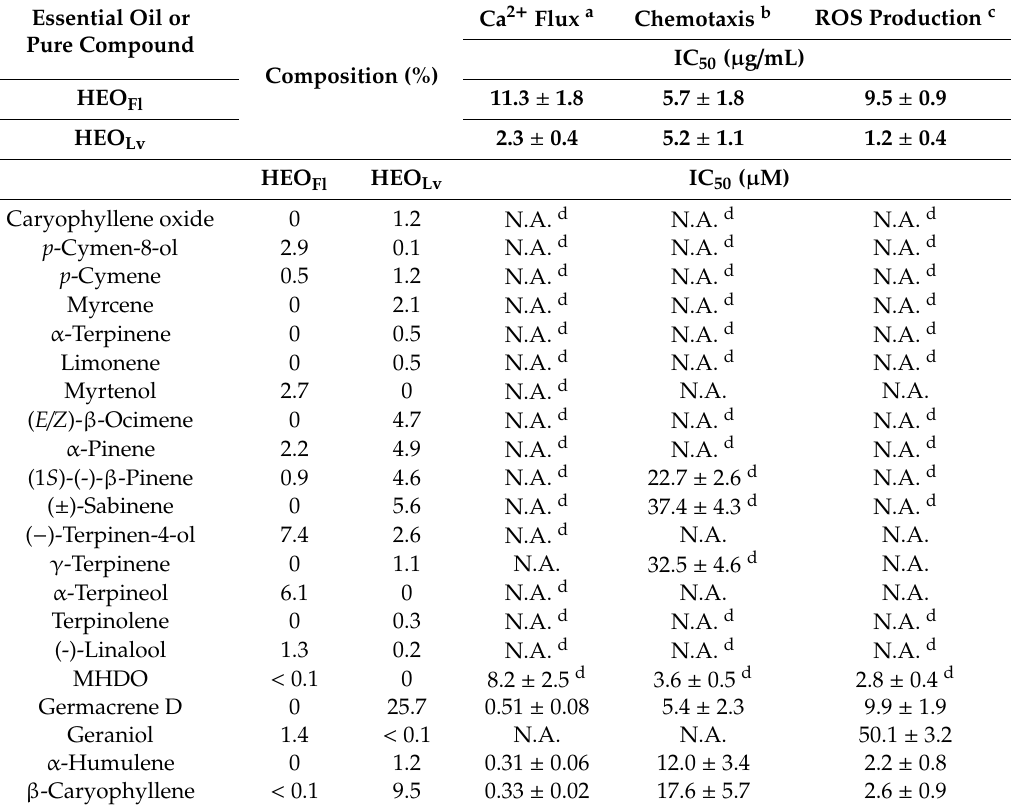
Table 4. Biological activity of HEO Fl and HEO Lv and their commercially available constituent compounds in human neutrophils.